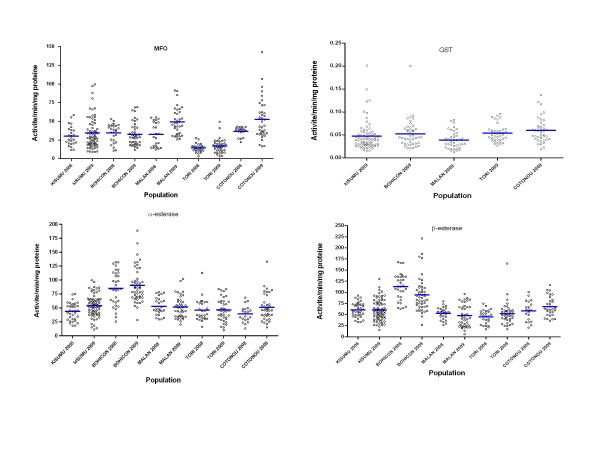
Variation of MFO, NSE (with substrate alpha and beta-naphthyl acetate) and GST activities per individuals of Anopheles gambiae s.l. collected in the four sentinel sites from 2008 to 2009, compared with the susceptible reference strain kisumu.